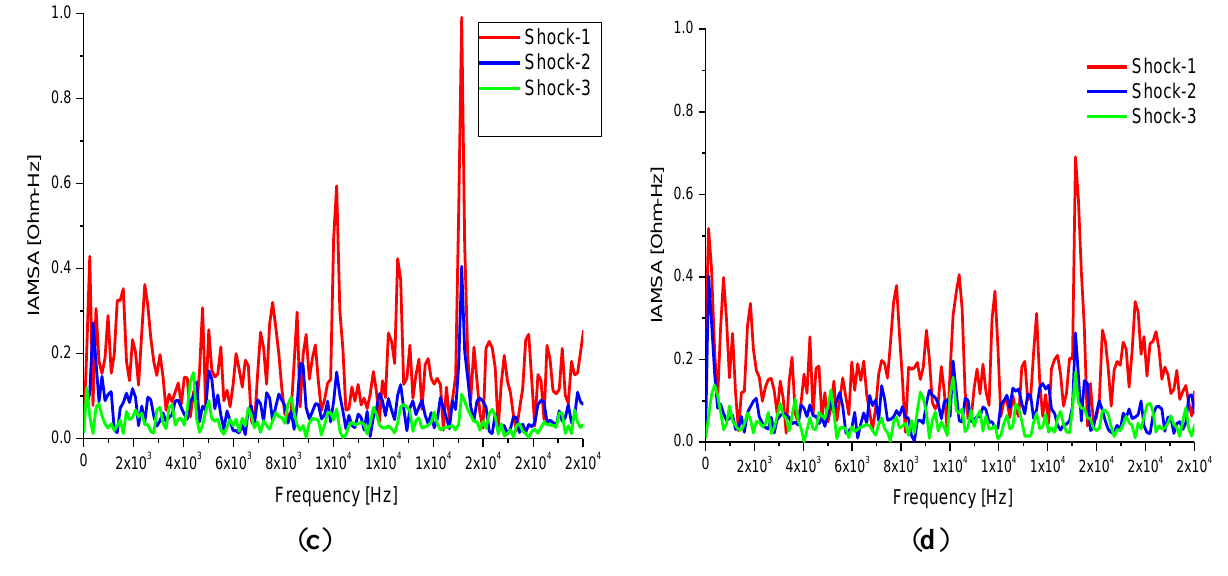
Figure 9. FFT computed impedance magnitude (Ω) spectra for B-VLTR and M-VLTR shocks in the 0–20 kHz frequency range for the first three shocks (S1 -> S3) delivered to patients in Groups-I to IV; ( a ) patient PAF12, B-VLTR Impedance Amplitude Spectrum